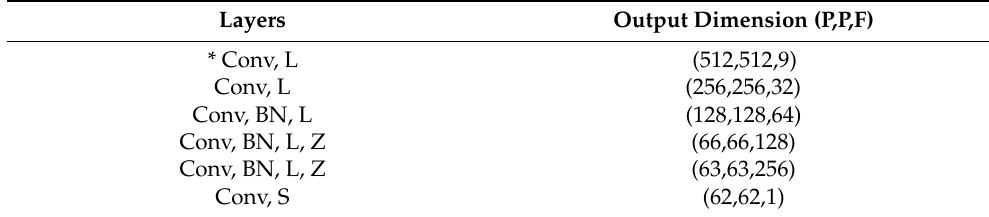
Table 4. List of the structures and hyperparameters of the PatchGAN-based discriminator (P: patch size; F: number of features; Conv: convolution; BN: batch normalization; L: leaky; S: sigmoid; Z: zero padding; *: convolution operation in the representation